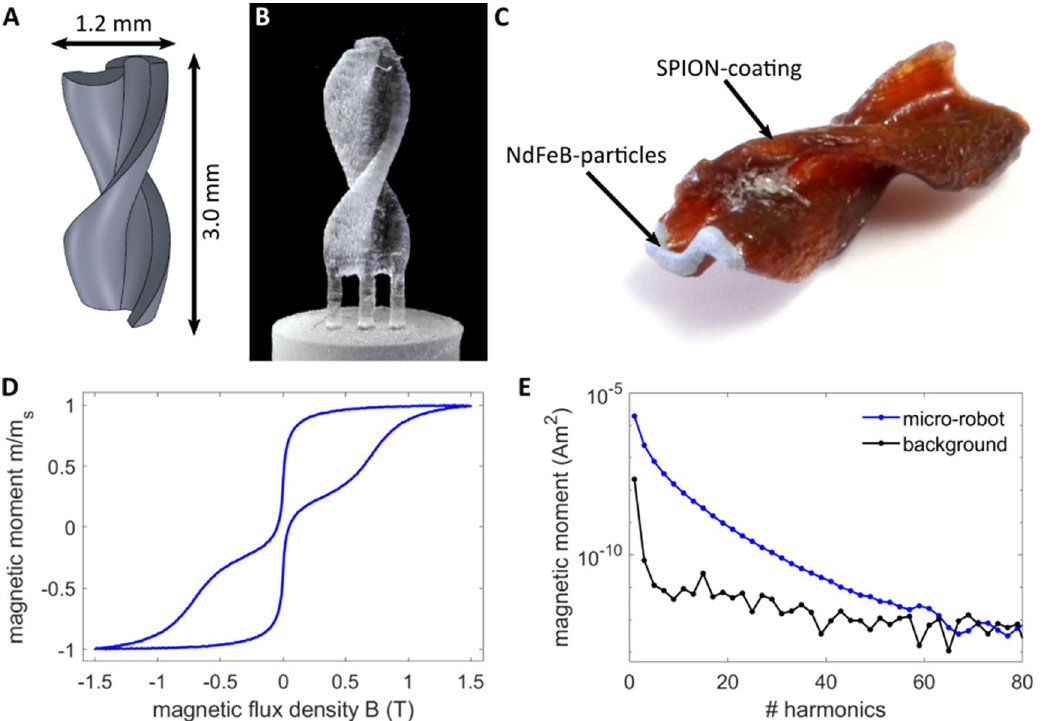
Figure 1. The magnetic micro-robot. ( A ) The CAD model of the micro-robot. The geometry is inspired by vertical axis wind turbines and is called helical Savonius shape. ( B ) The micro-robot is 3D-printed using a stereolithographic printing procedure. ( C ) It is coated with SPIONs for the visualization with MPI. The tip consists of NdFeB particles, introducing a magnetic moment for MA. ( D ) The magnetization curve of the micro-robot, acquired with a VSM showing a superposition of a paramagnetic and a ferromagnetic behavior. ( E ) The odd harmonics of the amplitude spectrum, acquired with a magnetic particle spectrometer with an excitation frequency of 25 kHz and an amplitude of 20